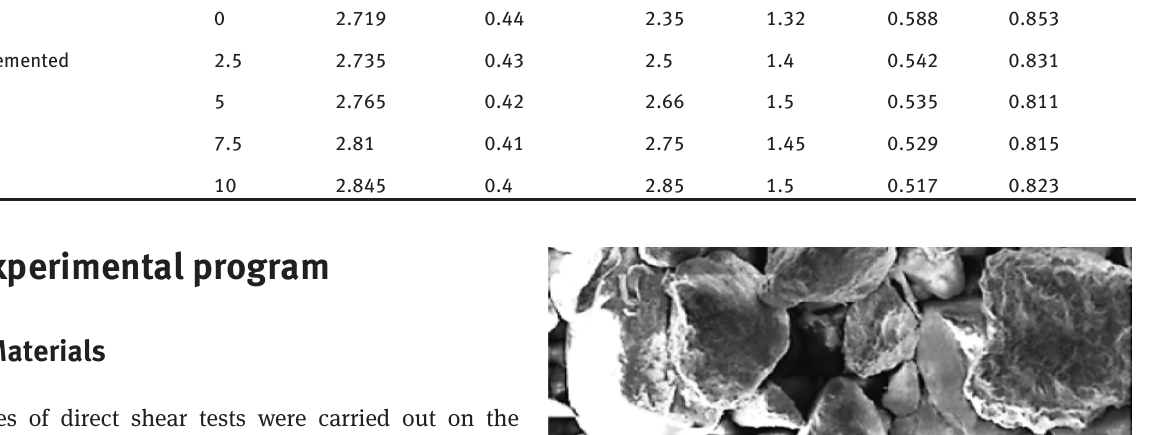
Table 1: Physical characteristics of Chlef sand and cemented sand. Materials